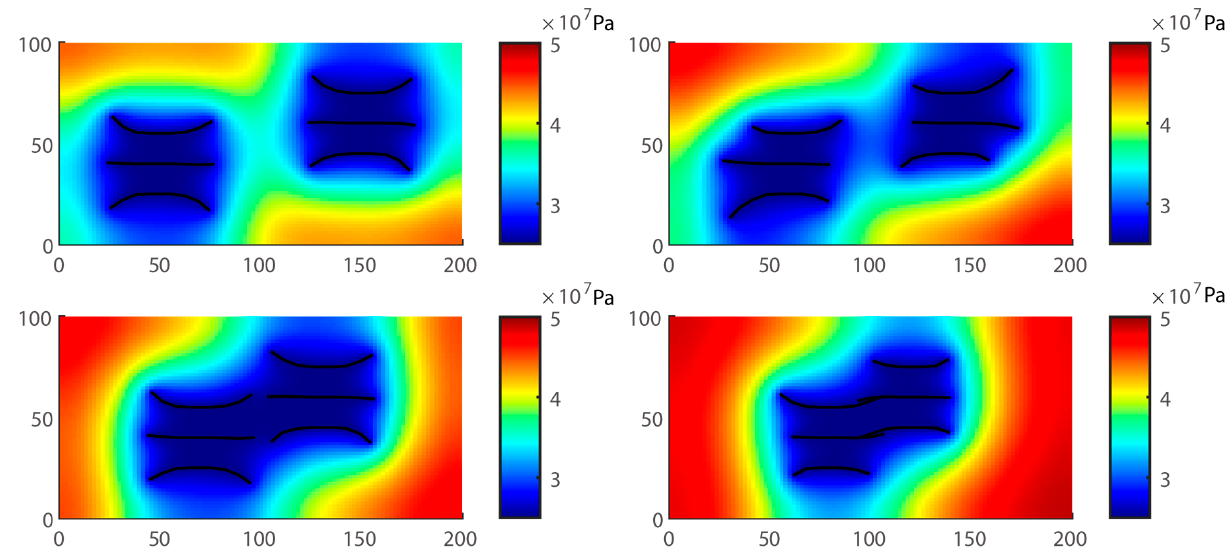
Figure 17. Displacement field after 60 s (well-spacing = 100, 80, 60, and 40 m).